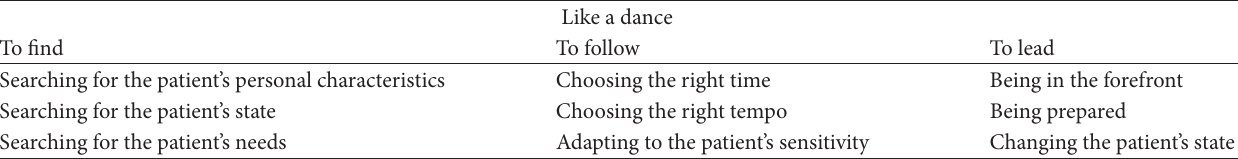
Table 2: Overview of the